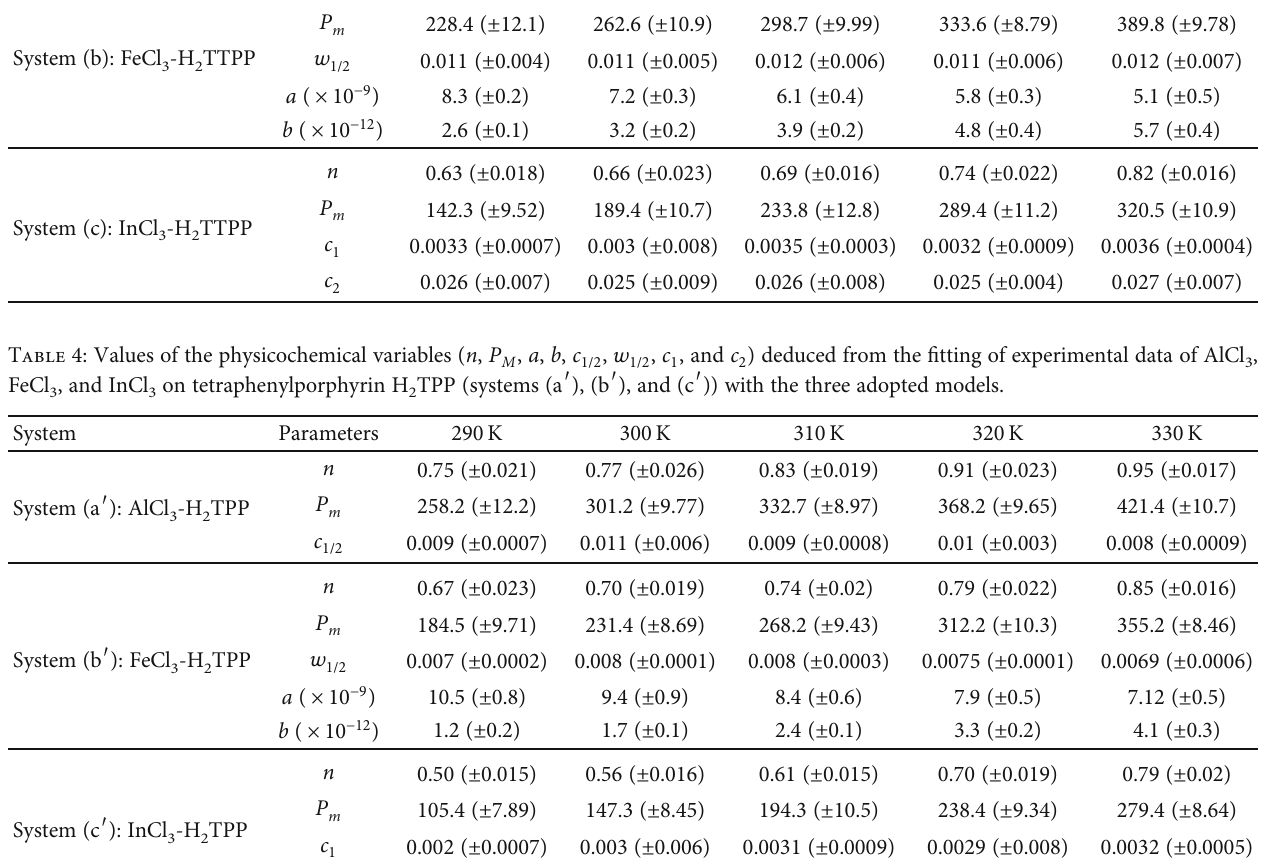
, a , b , c 1/2 , w 1/2 , c 1 , and c 2 ) a ff ecting the adsorption of AlCl M